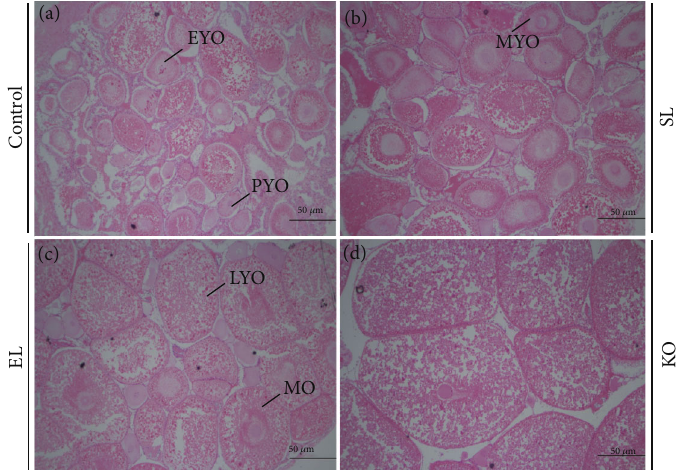
Figure 2: The ovarian histological characteristics of C. quadricarinatus fed four diets with di ff erent phospholipid sources for 10 weeks. Ovarian para ffi n sections with H&E staining of C. quadricarinatus fed the control (a), SL (b), EL (c), and KO diets (d) with 50 μ m scale bars (40x magni fi cation). PYO = preyolk synthesis stage oocyte; EYO = early-stage yolk synthesis stage oocyte; MYO = metaphase yolk synthesis stage oocyte; LYO = late-stage yolk synthesis stage oocyte; MO = mature